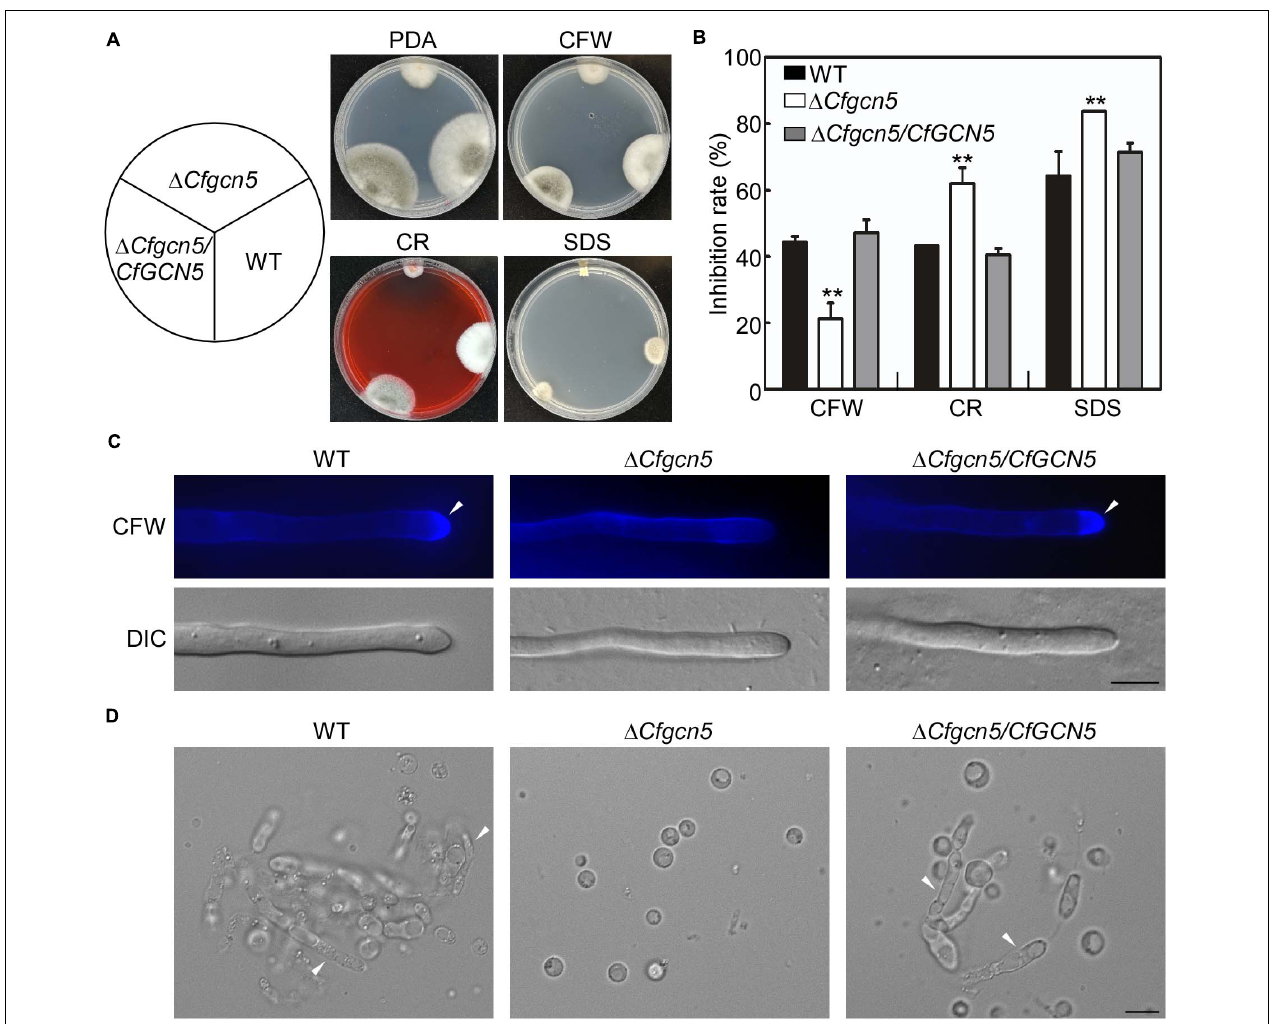
FIGURE 6 | CfGcn5 plays roles in cell wall integrity. (A) The WT, (cid:49) Cfgcn5, and (cid:49) Cfgcn5 / CfGCN5 were incubated on PDA plates with various cell wall stresses of CFW, CR, and SDS at 28 ◦ C for 4 days. (B) Statistical analysis of inhibition rates of the strains to cell wall stresses and asterisks indicate significant differences ( p < 0.01). (C) The mycelia of the strains were stained with 10 µ g/mL CFW for 5 min without light before being photographed, arrows indicates the stained hyphal tips. The experiment was repeated three times with triplicates, which showed the same results. DIC, differential interference contrast image. (D) Light microscopic observation of protoplast release after treatment with cell wall-degrading enzymes for 2 h at 30 ◦ C, arrows indicates the non-degraded hypha. Bar = 10 µ